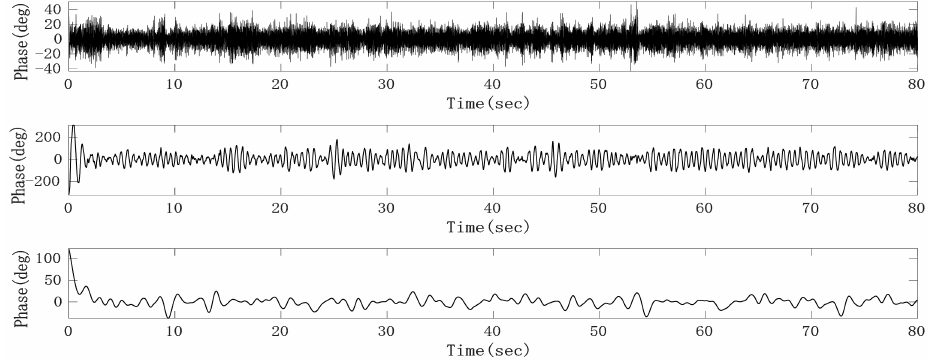
Figure 15. Heartbeat signal ( middle ), noise ( upper ) and other clutter ( lower ) separated by complete ensemble empirical mode decomposition with adaptive noise (CEEMDAN) and fast independent component analysis